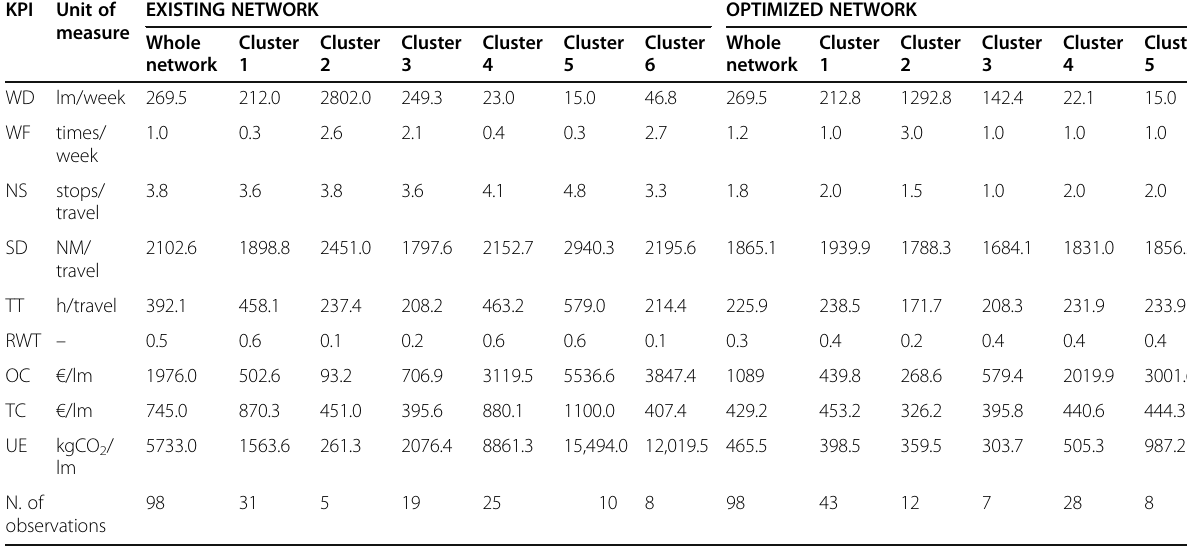
Table 17 Summary table KPI Unit of EXISTING NETWORK measure